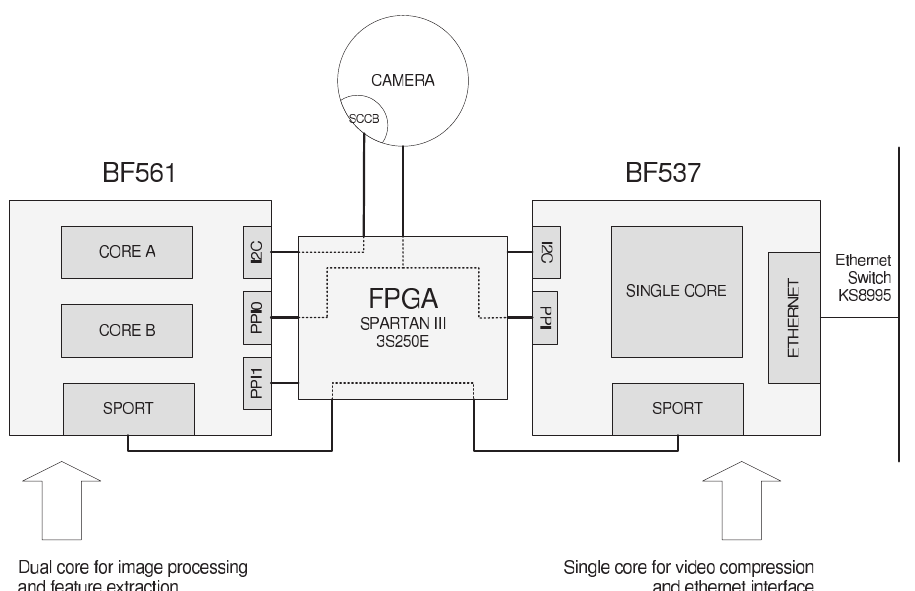
Figure 1. Video Board Hardware